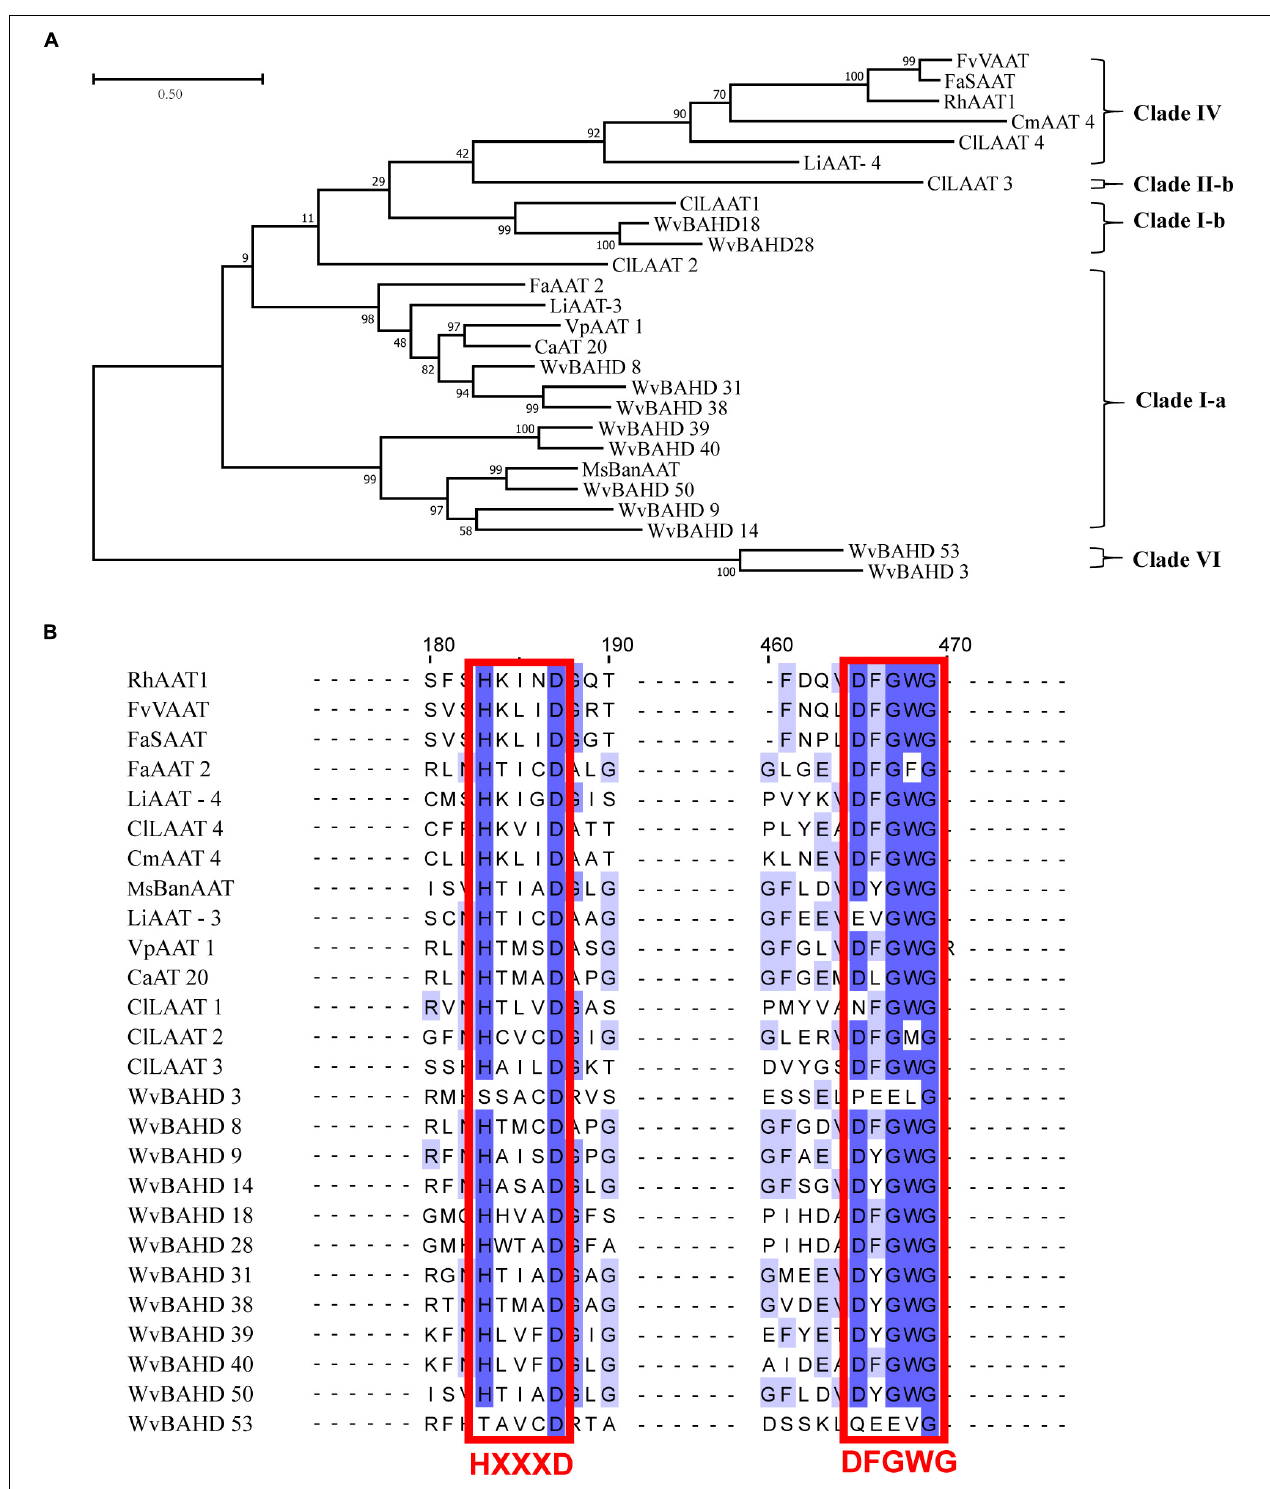
FIGURE 4 | (A) Phylogenetic analysis of 12 WvAAT candidate genes and 14 identified AATs from other plants. The phylogenetic tree was constructed by maximum likelihood with 1,000 replications, and the clade of clustering was adapted from Liu et al. (2020). (B) Sequence comparison of HXXXD and DFGWG motifs in WvAATs and identified AATs proteins. The percentage identify threshold was 30% or above. Conserved motifs are highlighted in red. Supplementary Table 2 contains the GenBank accession numbers of each AAT sequence used.